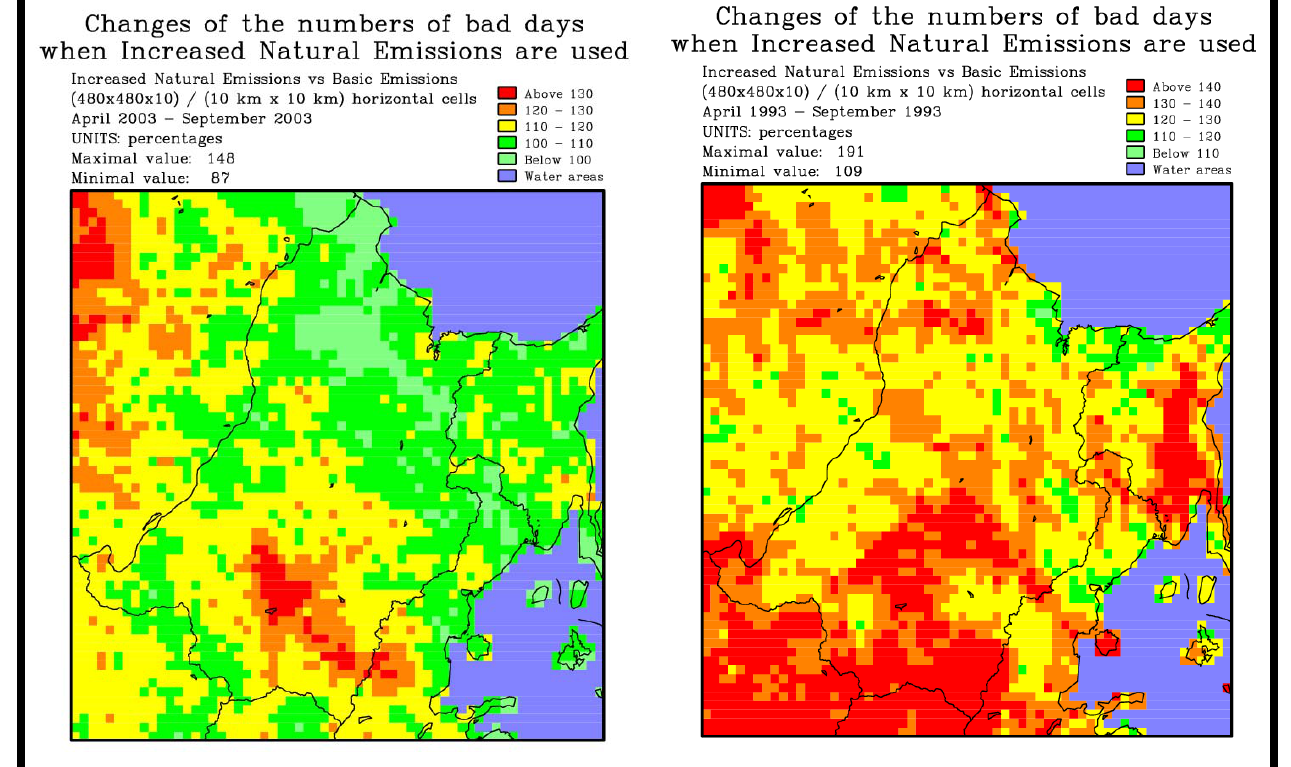
Figure 11. Increases (in percent) of the numbers of “bad days” in year 2003 (the left-hand-side plot) and in year 1993 (the right-hand-side plot) in a sub-domain containing Bulgaria when the scenario with increased natural (biogenic) emissions is used. The numbers of “bad days” in these two years when the Basic Scenario is used are given in the left-hand-side plots of Figure 7.